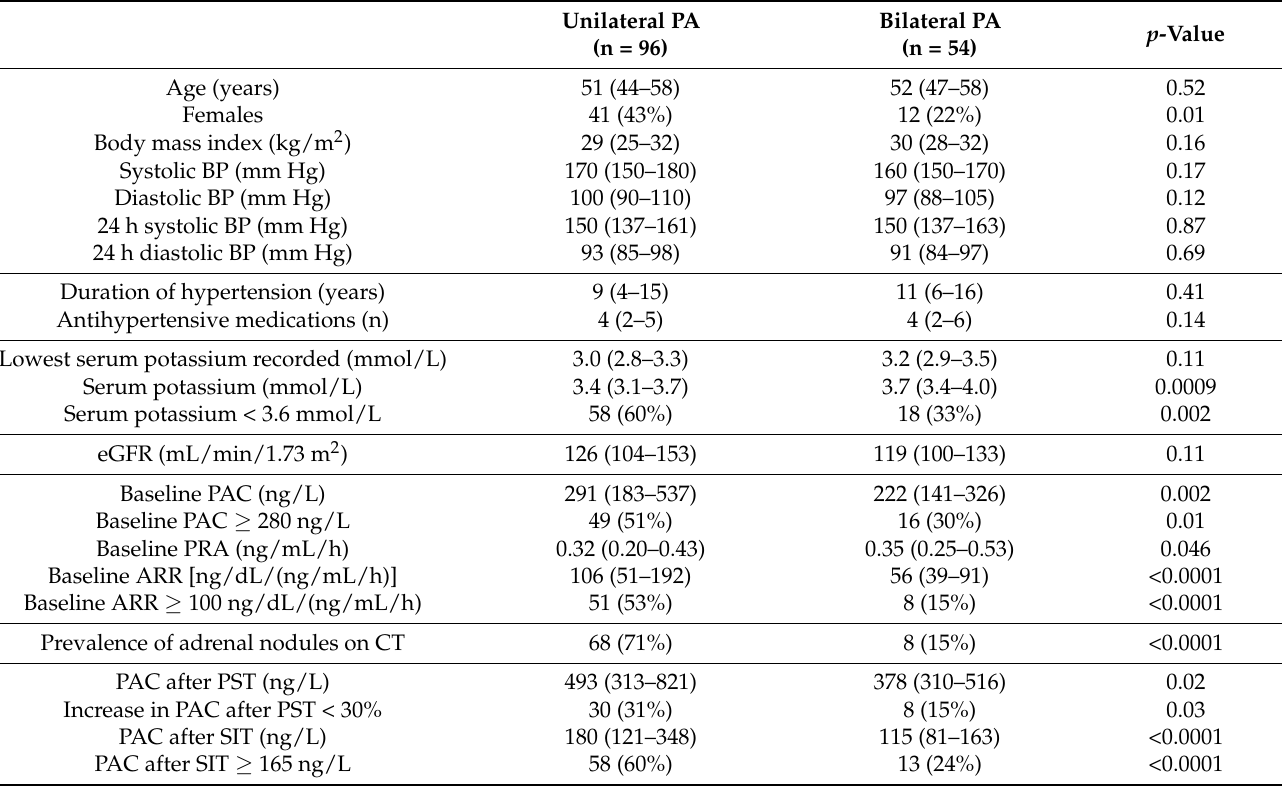
Table 1. Baseline characteristics of the development